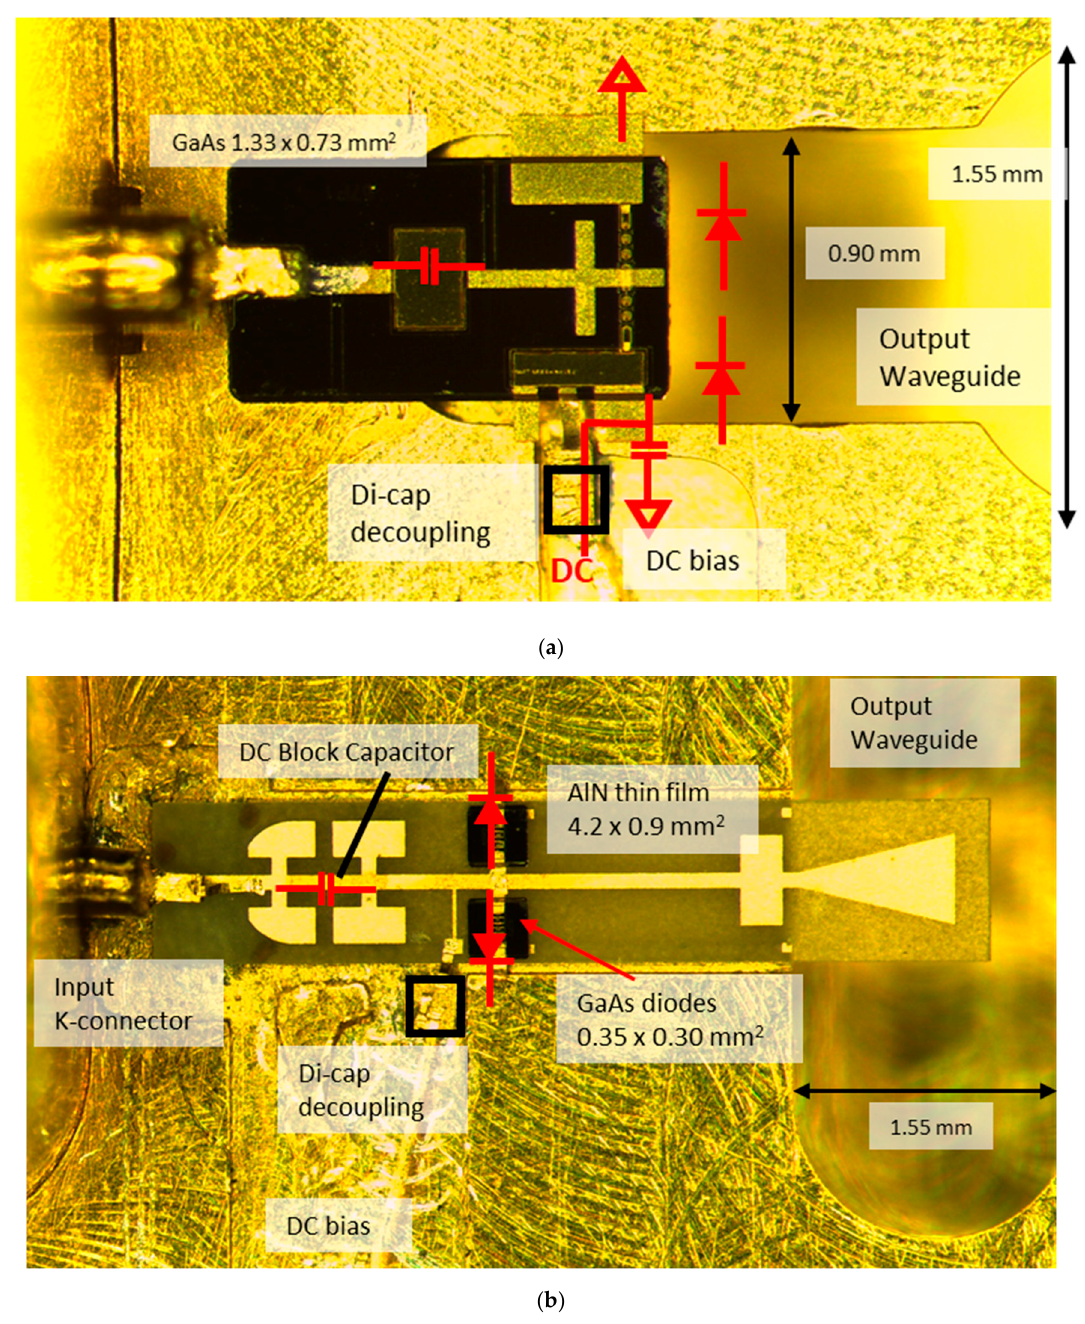
Figure 2. Photographs of the assembled circuits in the lower half of the split blocks. ( a ) GaAs MMIC, with dimensions 1.325 × 0.725 × 0.025 mm 3 ( b ) GaAs diode on AlN substrate hybrid, AlN dimensions 0.9 × 4.2 × 0.05 mm 3 .